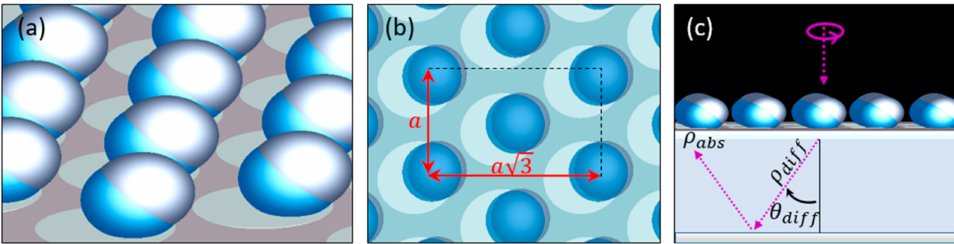
Figure 2. Schematic of numerical simulations: ( a ) 3D geometry of the sample; ( b ) top view of the metasurface; ( c ) schematic of the two different processes during the numerical